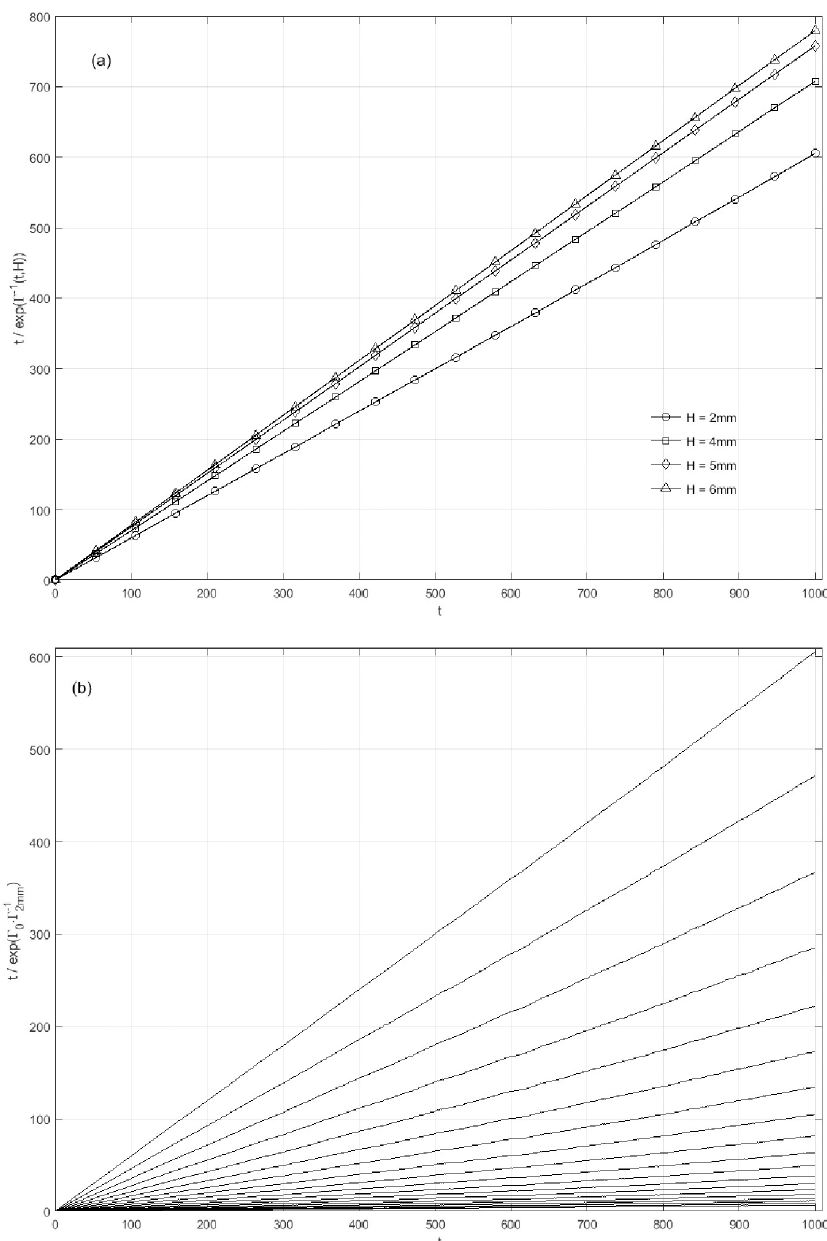
Fig 7. The dependence of t on the drop times t and the drop height H. (a) The function of t at different τ f ð t ; H Þ exp ð G (cid:0) 1 ð t ; H ÞÞ drop height H: H = 2 mm ( � ), H = 4 mm ( □ ), H = 5 mm ( � ) and H = 6 mm ( 4 ). Part of the data points are plotted for clarity. (b) The dependence of t on the Γ at H = 2 mm, and Γ ranges from 0.5 to 10 with the interval of 0.5. o o exp ð G o � G (cid:0) 1 ð t ; H ÞÞ This cluster of curves illustrates that Γ o makes no difference to the linear relationship between t and t f ð t ; H Þ